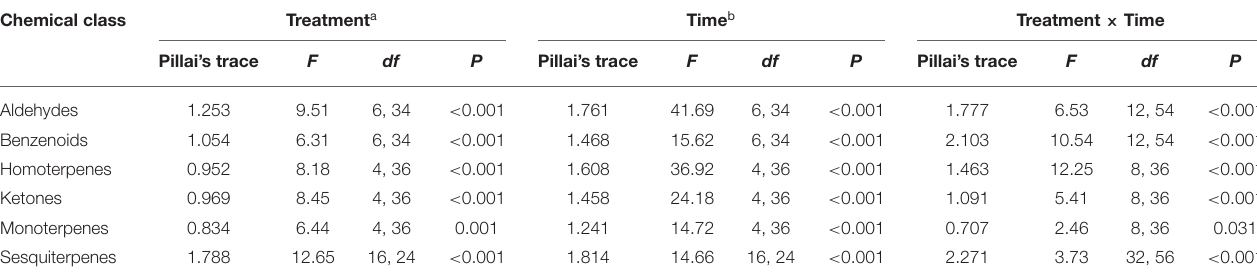
TABLE 1 | Results of Two-way MANOVA for the effects of plant treatment, VOCs sampling time, and their interaction on potato volatile emission. Chemical class Treatment a Time b Treatment ×